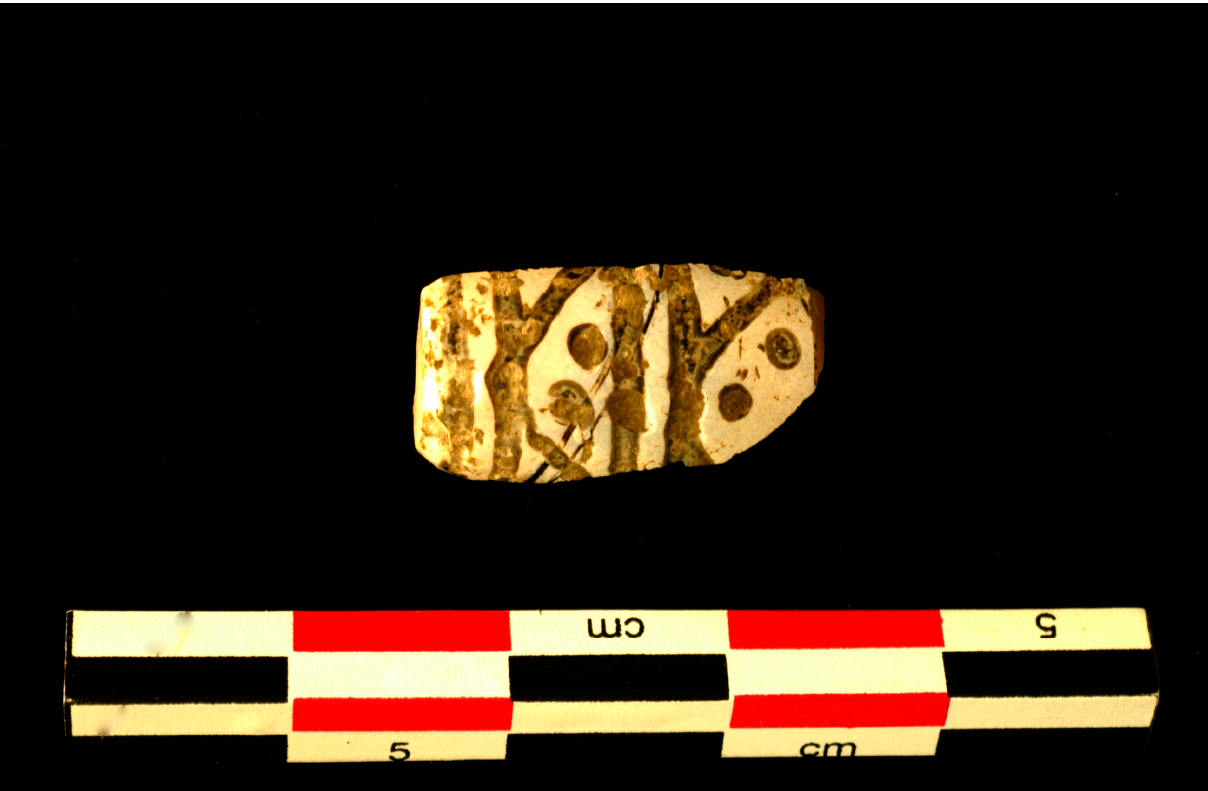
Figure 3. Etched stone bead from